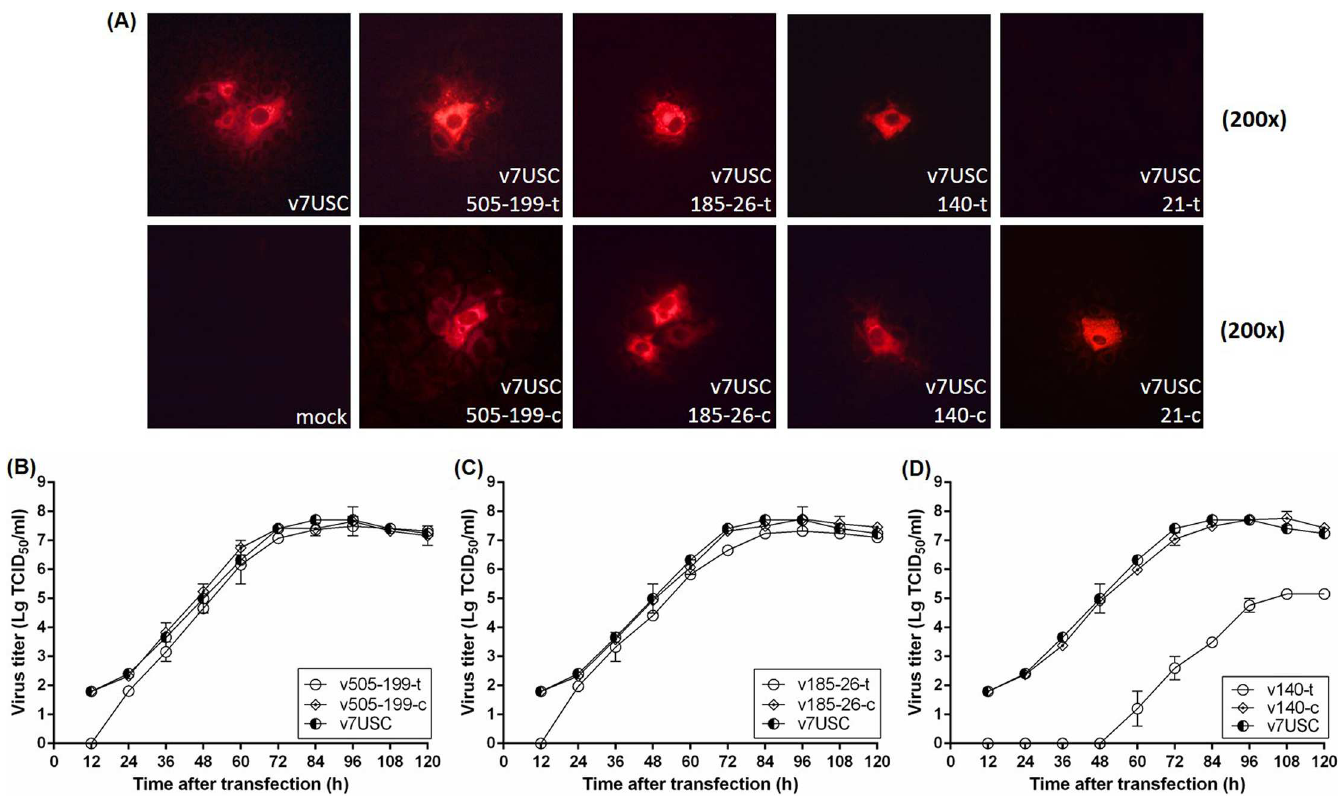
Fig 4. Mutants harboring sequences targeted by miRNAs of different abundant levels affect viral replication. Immunofluorescence staining for intracellular N protein in mutants. A: Confluent MARC-145 cells were transfected with plasmids p505-199-t, p505-199-c, p185-26-t, p185-26-c, p140-t, p140-c, p21-t, and p21-c, as indicated respectively, with p7USC and mock-transfected cells used as controls. Cells were fixed at 24 hpt and immunostained with the mouse monoclonal SR30A antibody against the viral N protein and fluorescein isothiocyanate-conjugated goat anti-mouse IgG. B: Viral growth after transfection of p7USC, p185-26-t, or p185- 26-c, as representatives of moderate-abundant miRNAs. C: Viral growth after transfection of p7USC, p140-t, and p140-c, as representative of high-abundant miRNAs. D: Viral growth after transfection of p7USC, p21-140-7c, p21-140-5c, and p21-140-3c, as representatives of mutant controls of high-abundant miRNA. Viral titers were expressed as Lg TCID 50 /mL. Data are shown as the mean ± SD of three independent